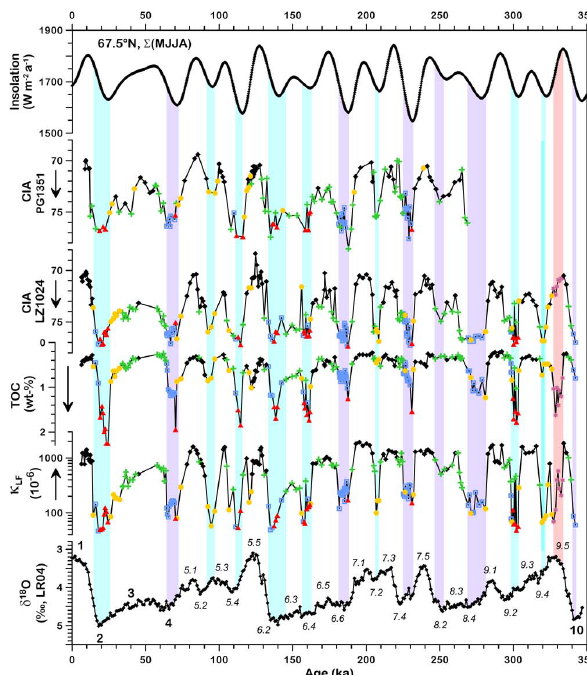
Fig. 7. Magnetic susceptibility ( κ LF ) , TOC, and CIA data of core Lz1024 composite versus time together with the CIA data of core PG1351, the summer insolation at 67.5 ◦ N according to Laskar et al. (2004, top) and the marine oxygen isotope ( δ 18 O) stack LR04 by Lisiecki and Raymo (2005, bottom). Oxygen isotope stages are marked by bold numbers, substages by italicized numbers. The coloured symbols in the Lz1024 and PG1351 records denote the different clusters (see also Fig. 4). The shaded stripes denote cli- mate modes at Lake El’gygytgyn: peak warm (pink), cold and dry (turquoise) and cold and moist (blue). For legend of the clusters see Fig.